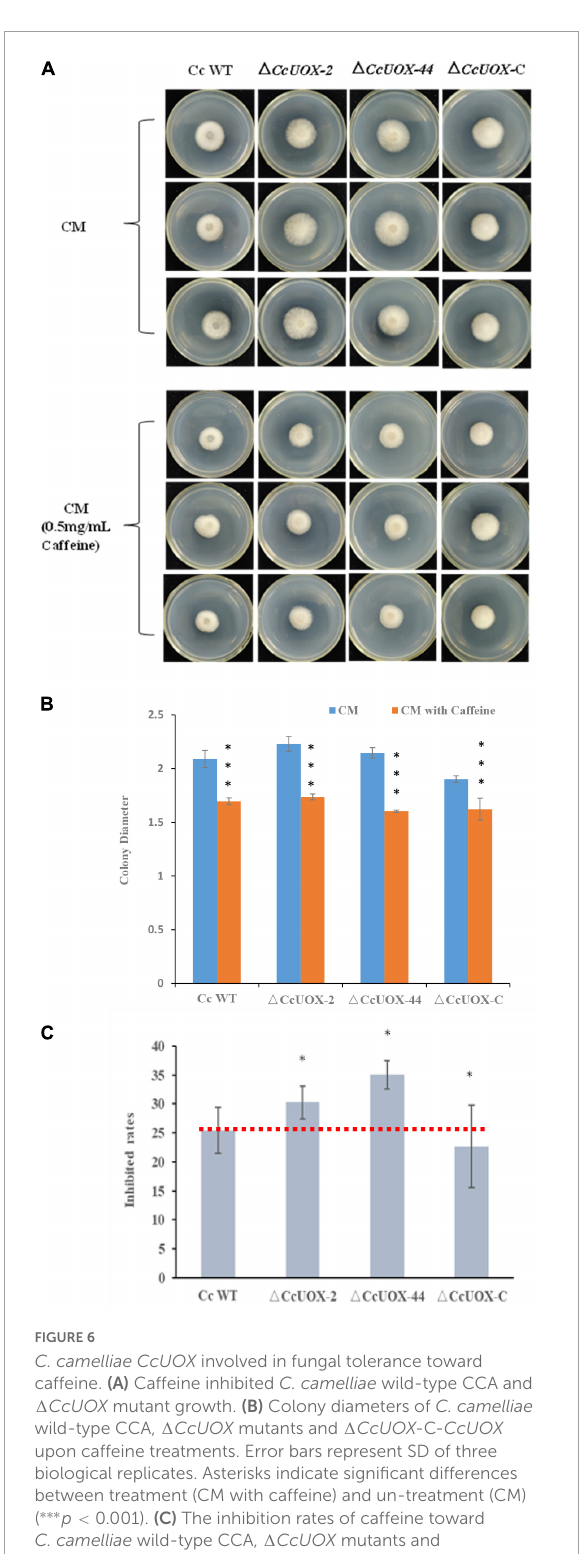
FIGURE6 C. camelliae CcUOX involved in fungal tolerance toward caffeine. (A) Caffeine inhibited C. camelliae wild-type CCA and (cid:49) CcUOX mutant growth. (B) Colony diameters of C. camelliae wild-type CCA, (cid:49) CcUOX mutants and (cid:49) CcUOX- C- CcUOX upon caffeine treatments. Error bars represent SD of three biological replicates. Asterisks indicate significant differences between treatment (CM with caffeine) and un-treatment (CM) ( ∗∗∗ p < 0.001). (C) The inhibition rates of caffeine toward C. camelliae wild-type CCA, (cid:49) CcUOX mutants and (cid:49) CcUOX- C- CcUOX . Error bars represent SD of three biological replicates. Asterisks indicate significant differences between C. camelliae indicated strains and C. camelliae wild-type CCA ( ∗ p <